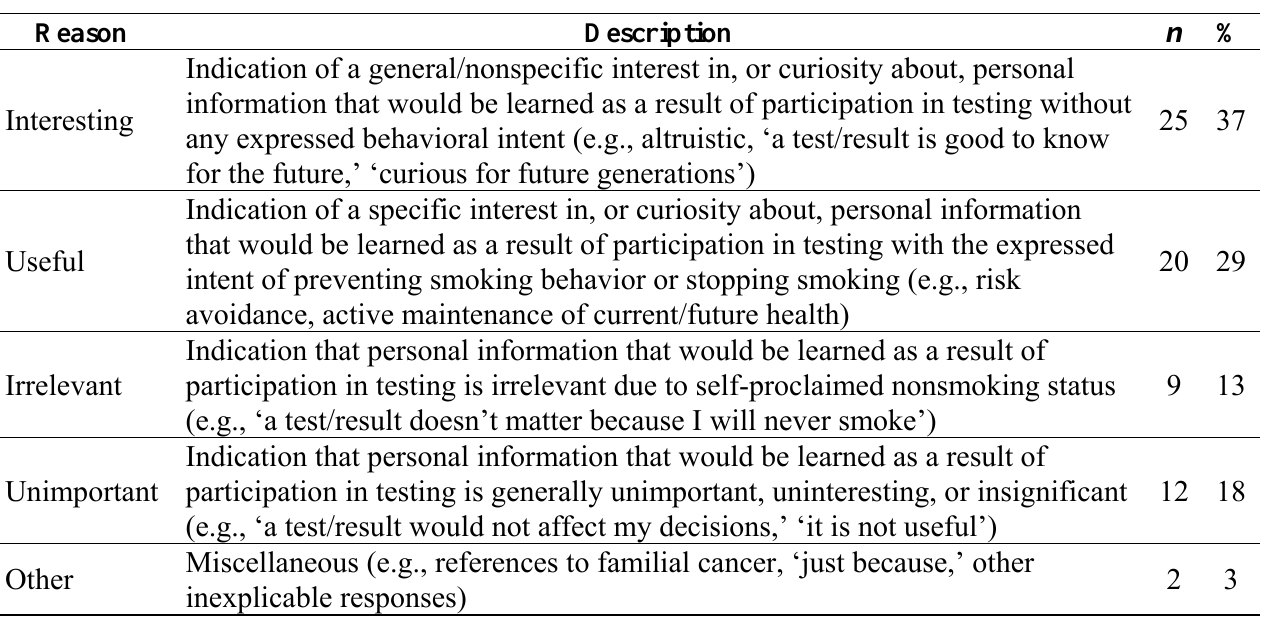
Table 1. Adolescents’ elaborated reasons behind the strength of their interest in nicotine addiction susceptibility testing ( n =